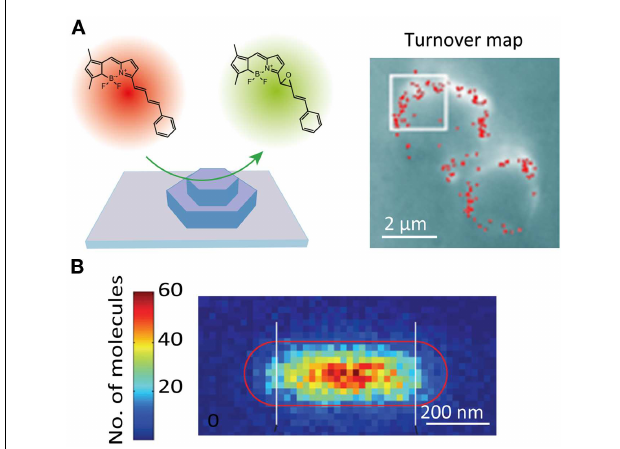
FIGURE 5 | Super-resolution fluorescence imaging of catalytic reactions. (A) (Left) schematic illustration of the strategy for monitoring individual epoxidation reaction events catalyzed by mesoporous titanosilicates,Ti-MCM-41.The active sites are fluorescently visualized and localized by the catalytic reaction-induced color conversion of the fluorophore; (right) localization microscopy image of individual turnover.The red dots show positions of fluorescent spots originating from individual product molecules (De Cremer et al., 2010). (B) Super-resolution imaging of deacetylation reaction catalyzed by Au@mSiO 2 nanorod.The positions of the reaction product on the nanorod are visualized by localization microscopy and plotted in the 2D histogram, which shows the position-dependent catalytic activity (Zhou et al., 2012). Reproduced with permission from De Cremer et al. (2010), copyright 2010,Wiley (A) , and Zhou et al. (2012), copyright 2012, Nature Publishing Group (B) .